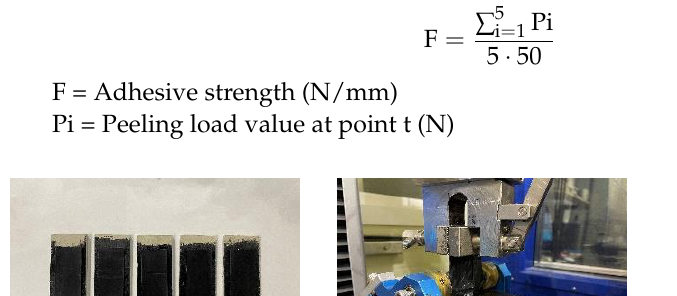
Figure 5. Peel-out (with CRC board surface) test method.